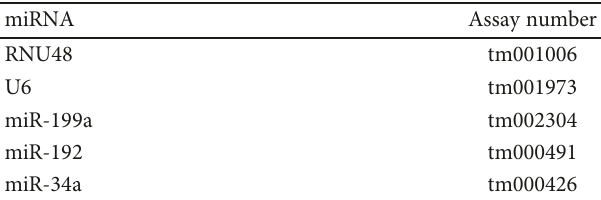
Table 3: miRNA-speci fi c TaqMan microRNA